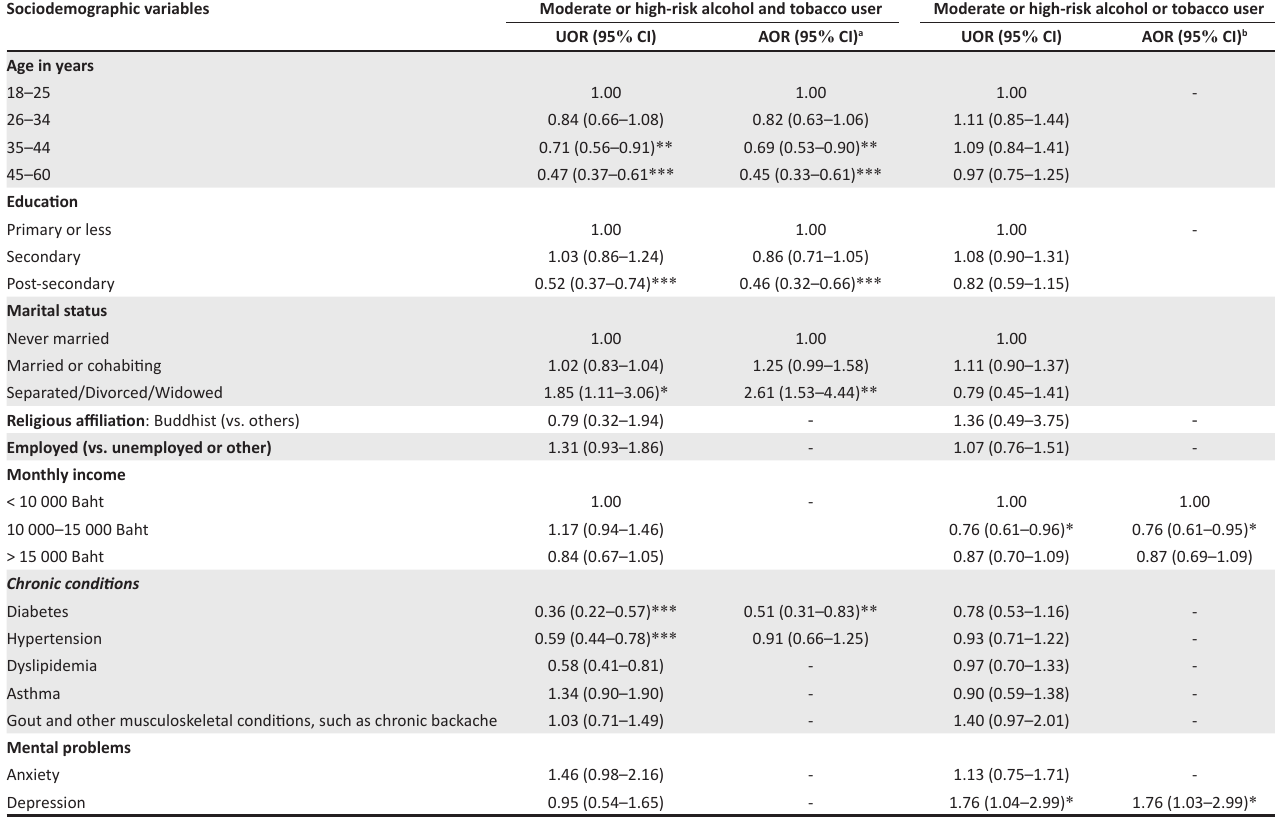
TABLE 3: Association of sociodemographic and health variables and moderate or high-risk alcohol or tobacco use among male out-patients, 2014 ( N = 2180). Sociodemographic